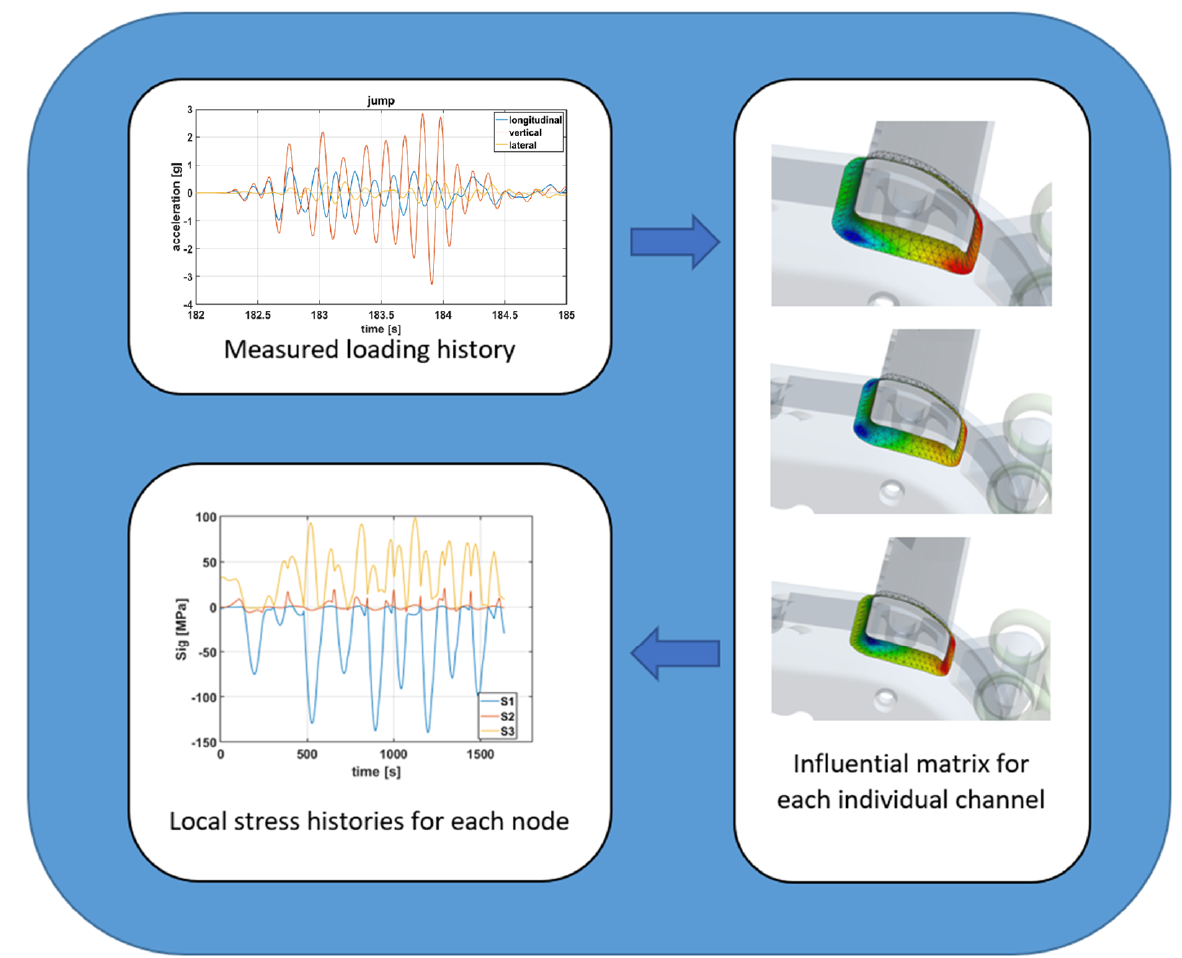
Figure 1. Estimating loading histories in the critical place.